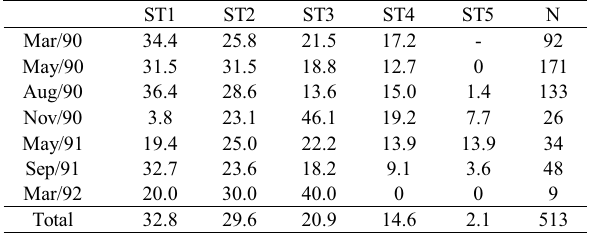
Table 1 . Relative frequency of occurrence of C. spilopterus , along the Mamanguá Inlet, in the oceanographic stations. N = number of specimens. Station 5 wasn’t sampled in Mar/90.